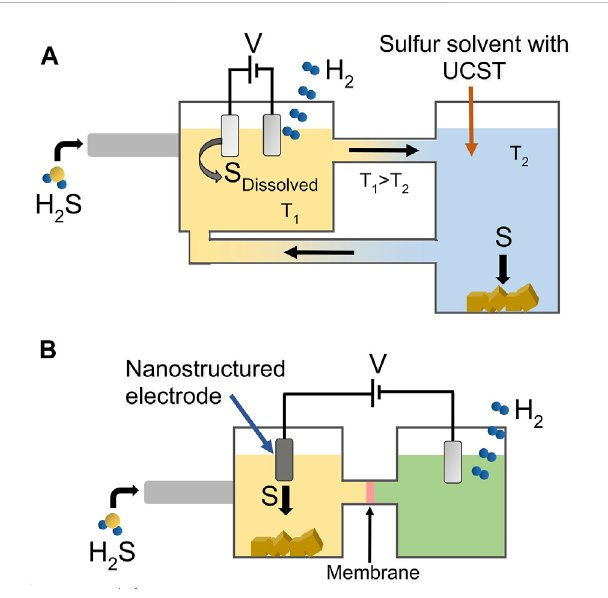
FIGURE 1 Current approaches to solve the SOR electrode passivation by sulfur deposition by using either (A) a sulfur solvent with a upper critical solution temperature (UCST), where sulfur solubility drastically